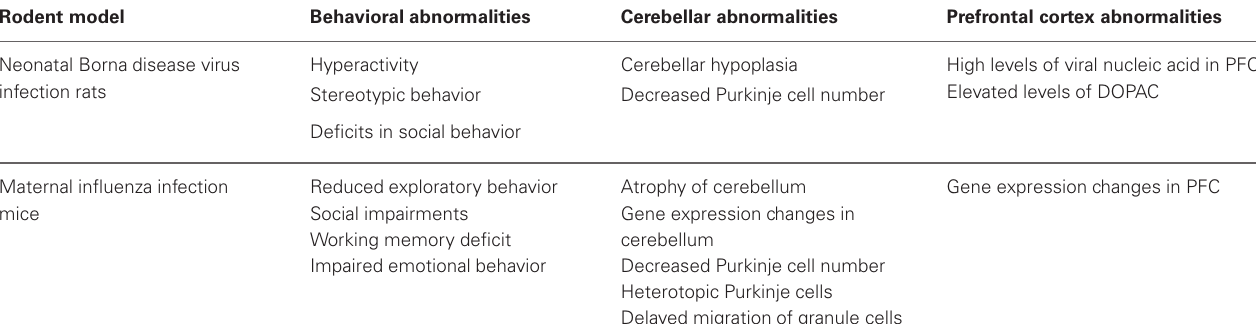
Table 2 | Summary of viral infection rodent models with cerebellar and behavioral abnormalities that parallel those observed in autism. Rodent